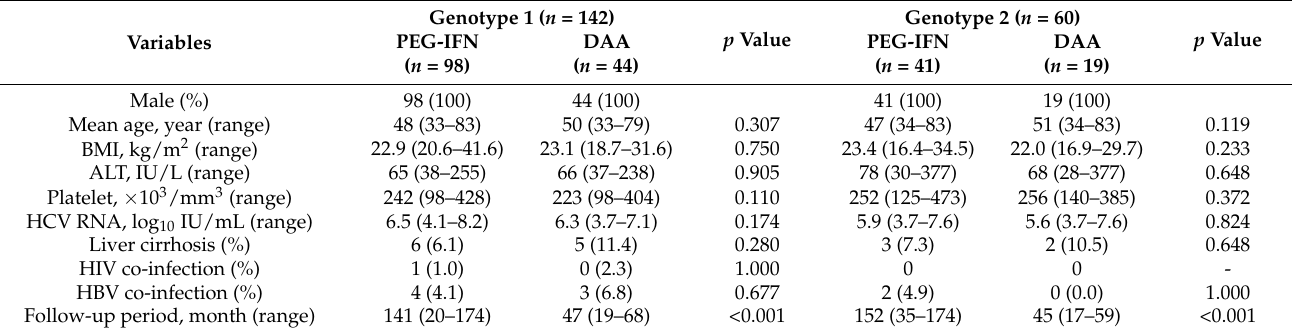
Table 1. Baseline clinical characteristics of patients with chronic hepatitis C and hemophilia.